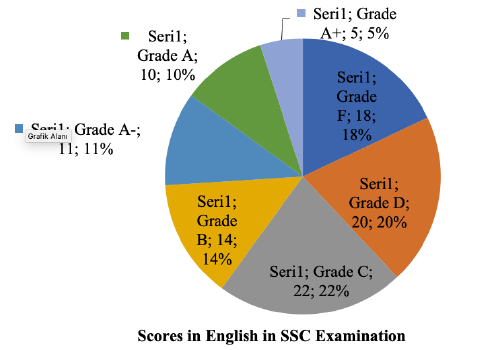
Figure 7: Scores in English in SSC